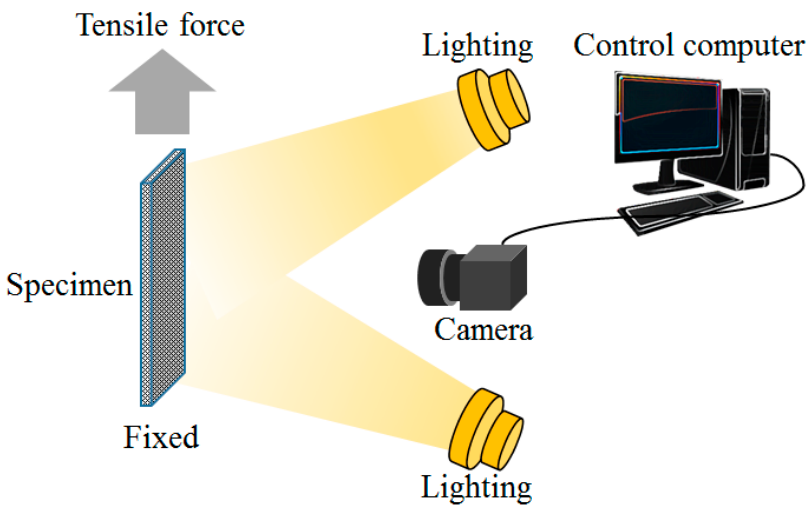
Appl. Sci. 2019 , 9 , x FOR PEER REVIEW Figure 12. Schematic diagram of experimental setup. Figure 12. Schematic diagram of experimental setup.